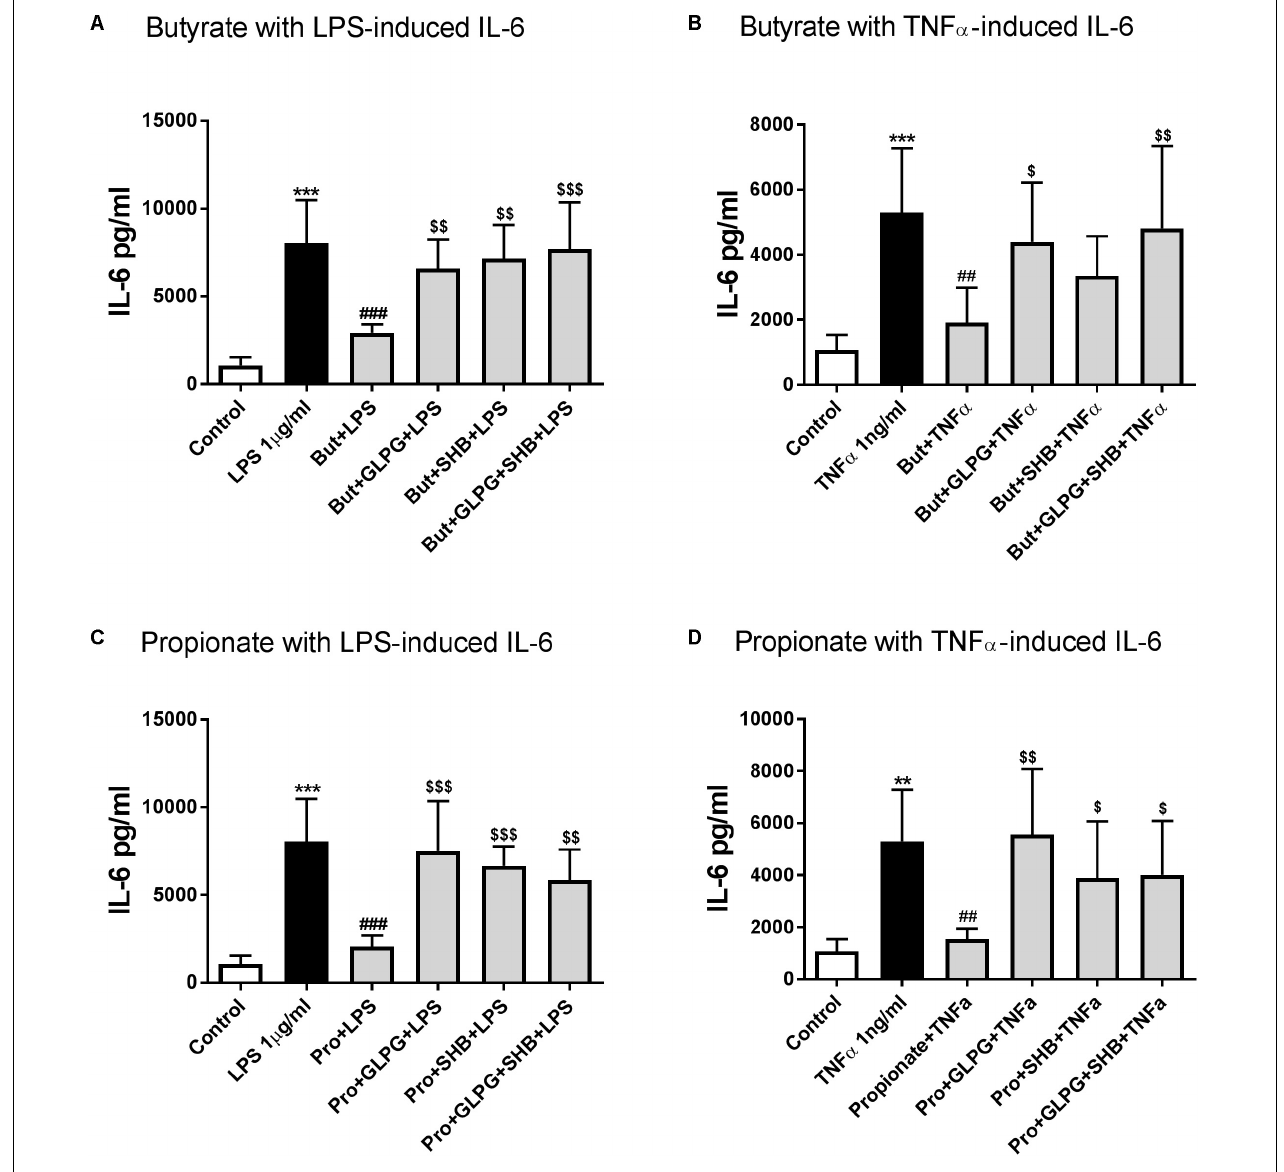
FIGURE 2 | Butyrate and propionate inhibited IL-6 in LPS and TNF α -stimulated HUVEC. Pre-treatment with butyrate (0.1 mM) and propionate (0.3 mM) for 24 h significantly reduced IL-6 levels in 12 h LPS- or TNF α -stimulated groups. (A) and (B) show the effects of butyrate; (C) and (D) show the role of GLPG and/or SHB on the effects of propionate; N = 4, ∗∗ p < 0.01, ∗∗∗ p < 0.001 compared with control group; ## p < 0.01, ### p < 0.001 compared with LPS or TNF α group; $ p < 0.05, $$ p < 0.01, $$$ p < 0.001 compared with butyrate or propionate alone